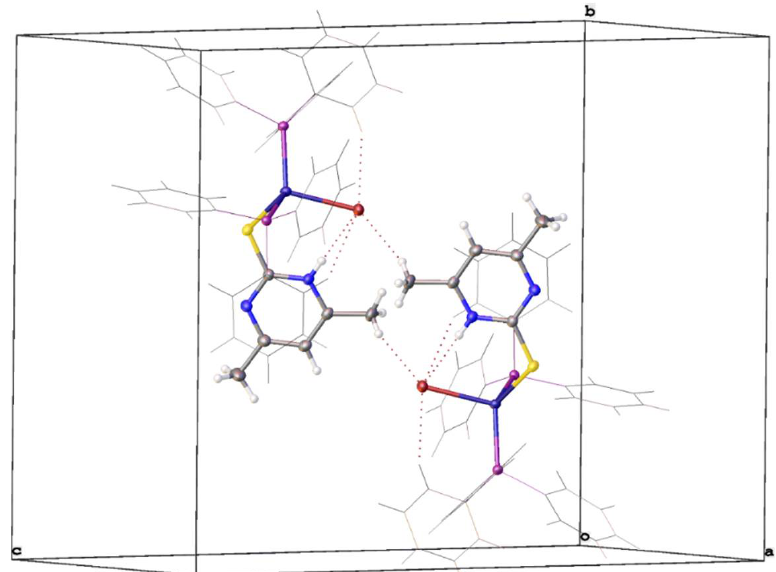
Figure 2. Neighboring molecules of the unit cell form a centrosymmetric dimer via intermolecular hydrogen bonding with D ··· A distance of 3.879(1) Å. The thermal ellipsoids are drawn at 50% probability level. For clarity, the phenyl rings are drawn as wires and sticks.